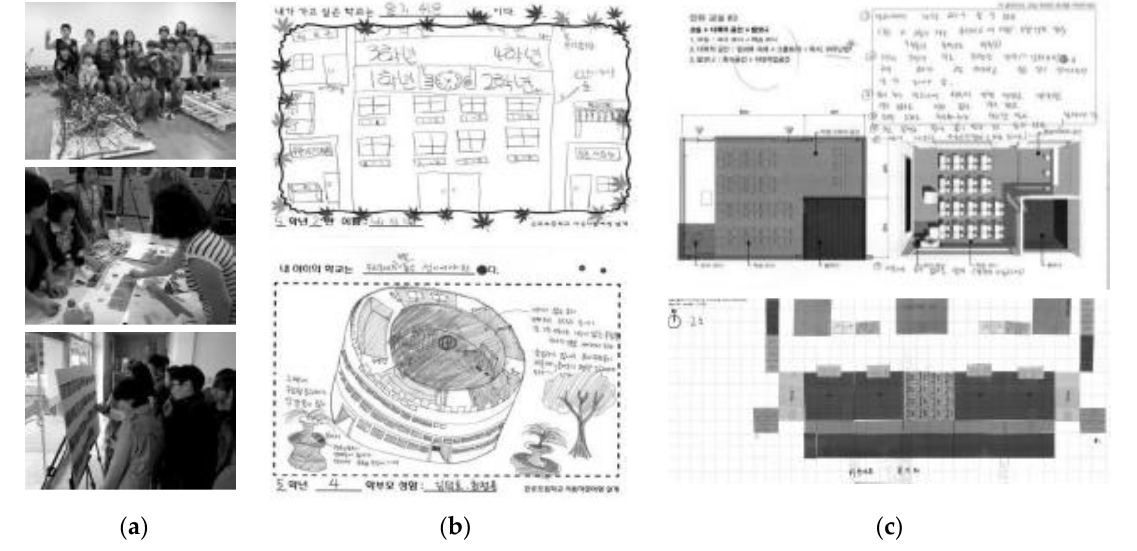
Figure 4 . ( a ) Design education and workshops; ( b ) Examples of student and teacher sketches; (c) Classroom cluster design game results (Source: [43])